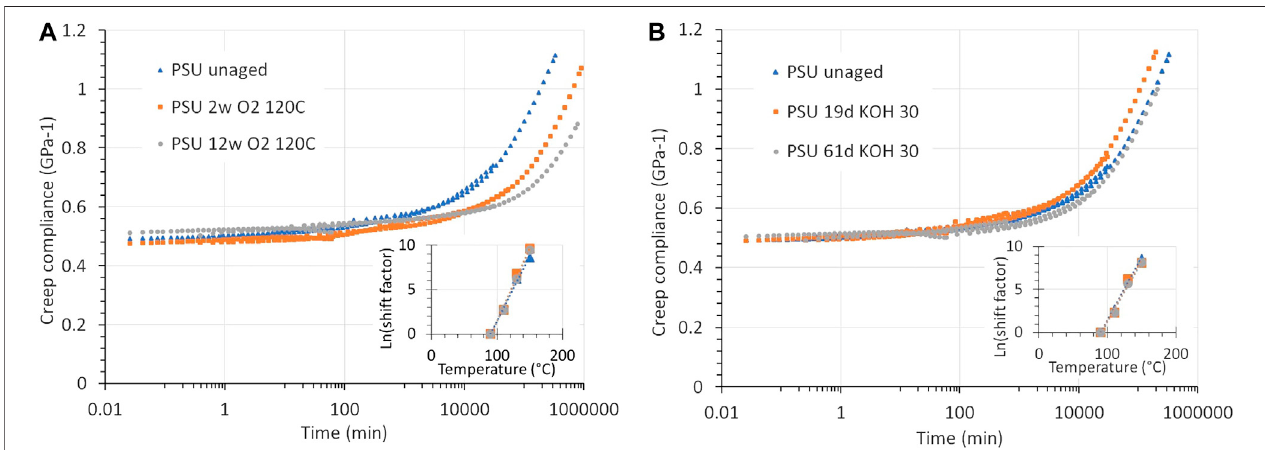
FIGURE 12 | Predicted long-term creep for PSU aged in (A) O 2 (5 bar, 120 ° C) and (B) KOH (30 wt%, 90 ° C). The insets show the corresponding Arrhenius shift plots. The prediction was achieved by composing master curves with time-temperature superposition. Exposure to O 2 reduces the creep, while for KOH the predicted creep closely matches that of unaged PSU.